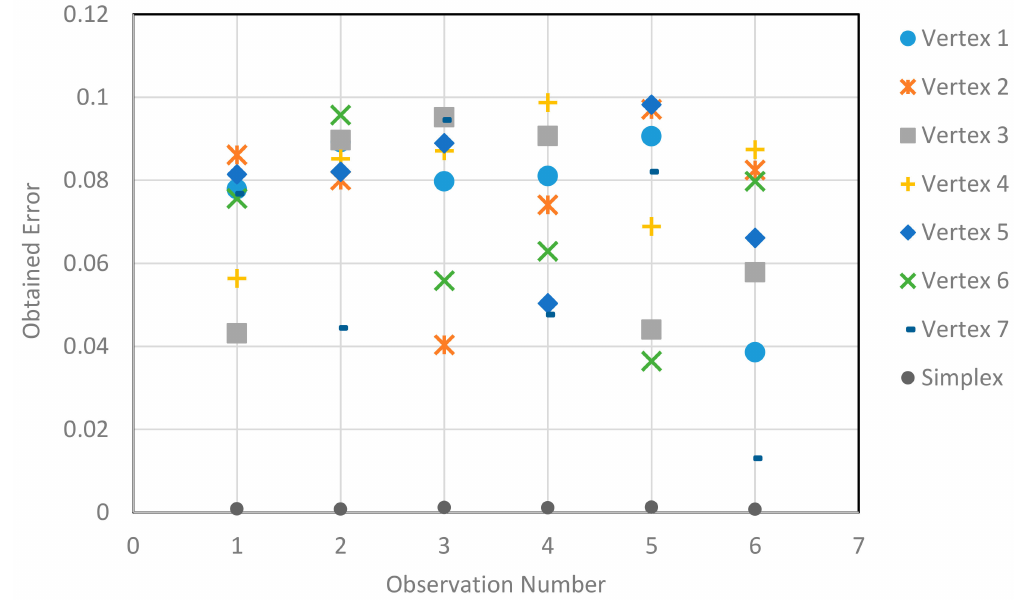
Figure 13. Reduction in error on applying simplex optimization on solutions obtained from SA. Table 7. Number of iterations required by SA to obtain maximum targeted error for further application of Simplex method.